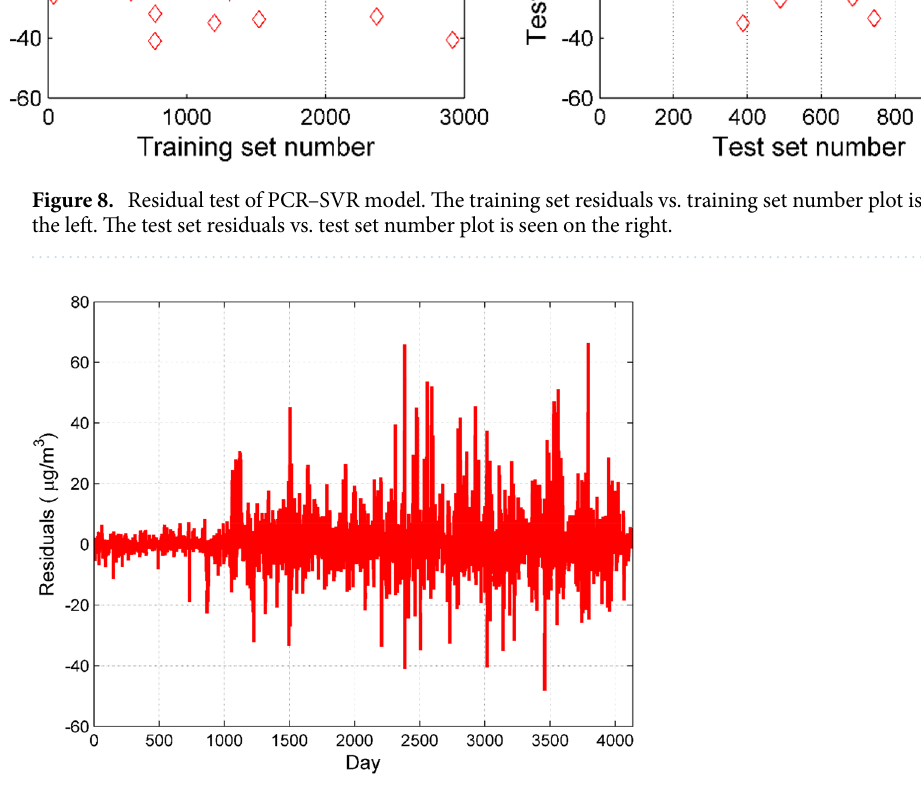
Figure 9. Stationary test of residual time series data of PCR–SVR model for prediction of NO 2